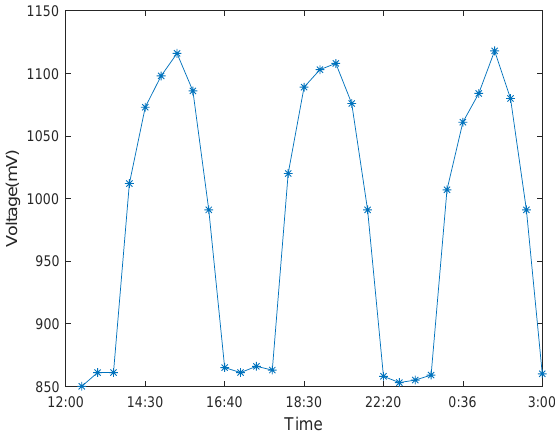
Figure 8. Tree-energy voltage variation in summer.